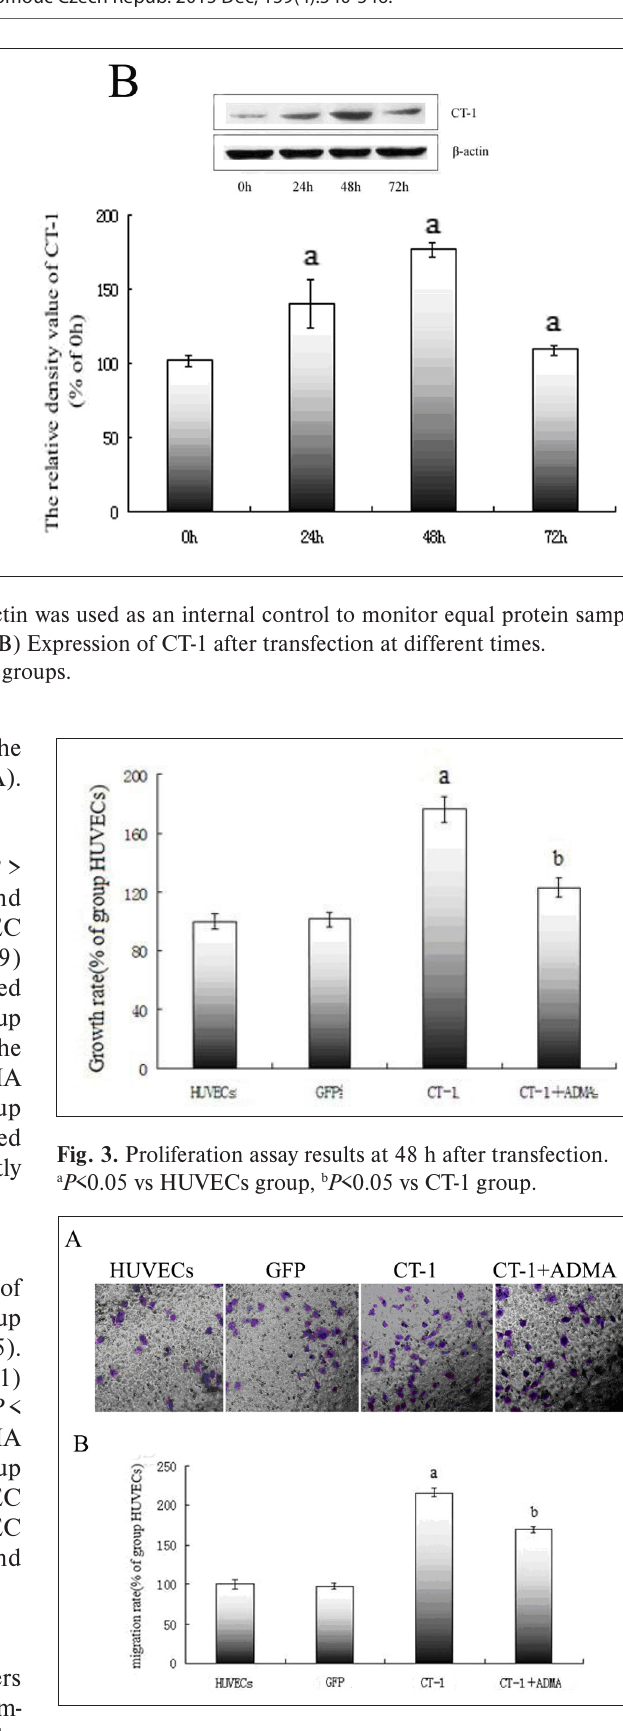
Fig. 4. Migration assay results at 48 h after transfection. (A) Representative photomicrographs at 48 h after transfection. (B) The migrated cell number in different group. a P <0.05 vs HUVECs group, b P <0.05 vs CT-1